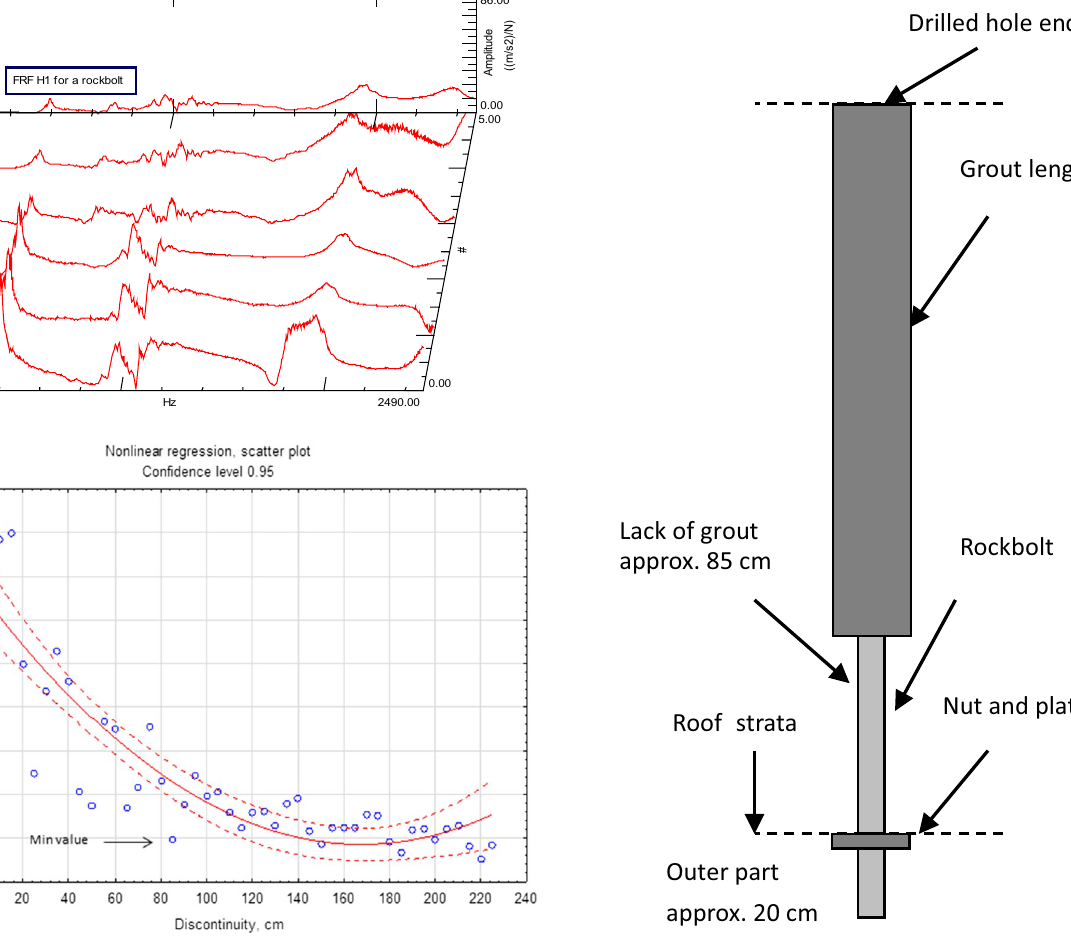
Fig. 12 The results of estimation of the grout length: the characteris- tics of the transfer function for the analyzed case (waterfall chart for points of excitation), the vertical axis of the chart—inertance, in (m/